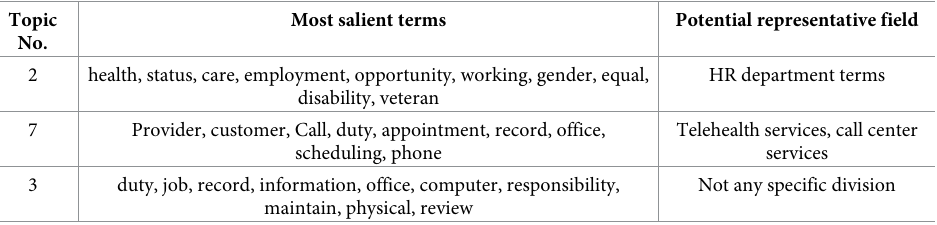
According to Table 3, telehealth was still in high demand during Period 2, but the data ana- lytics jobs decreased. This can be attributed to a decrease in social distancing and tracking measures initially started by the US government as a prompt response to COVID-19. How- ever, data analytics was still a significant part of job postings in the second data collection period. Telehealth seems to have impacted healthcare in the long term [20]. Table 3. US data top three topics (Period 2). Topic